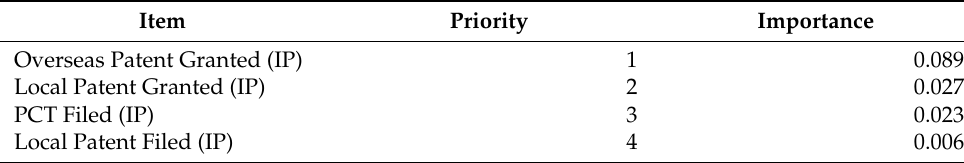
Table 7. Results of intellectual property readiness.